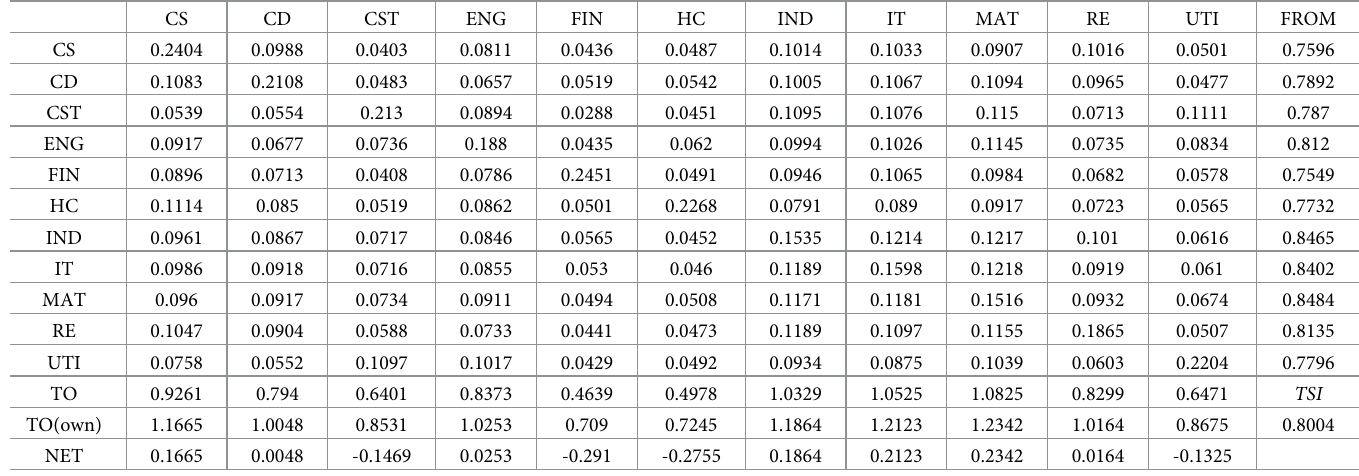
Table 3. Summary of liquidity spillovers in all the sectors during the GFC (from August 2007 to March 2009). The optimal lag order according to the AIC is